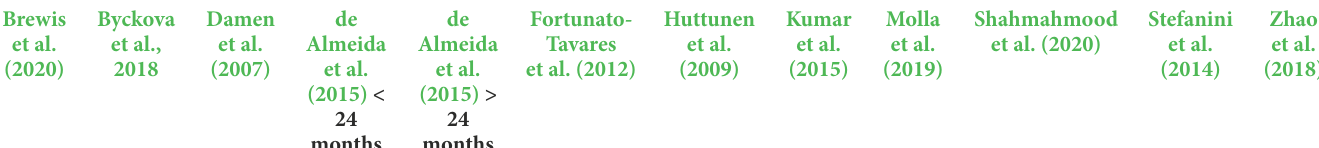
TABLE 7 Social relations subscale Tukey HSD post-hoc mean